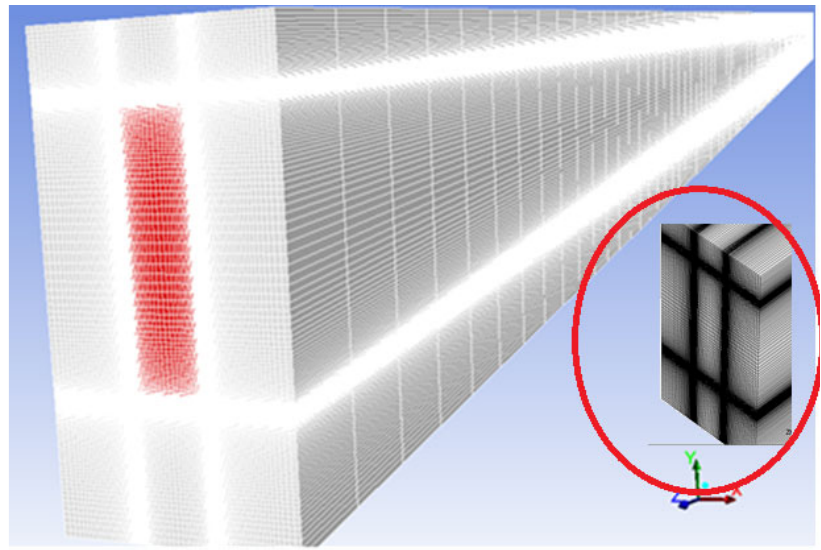
Figure 2. CFD surface mesh for the microchannels.